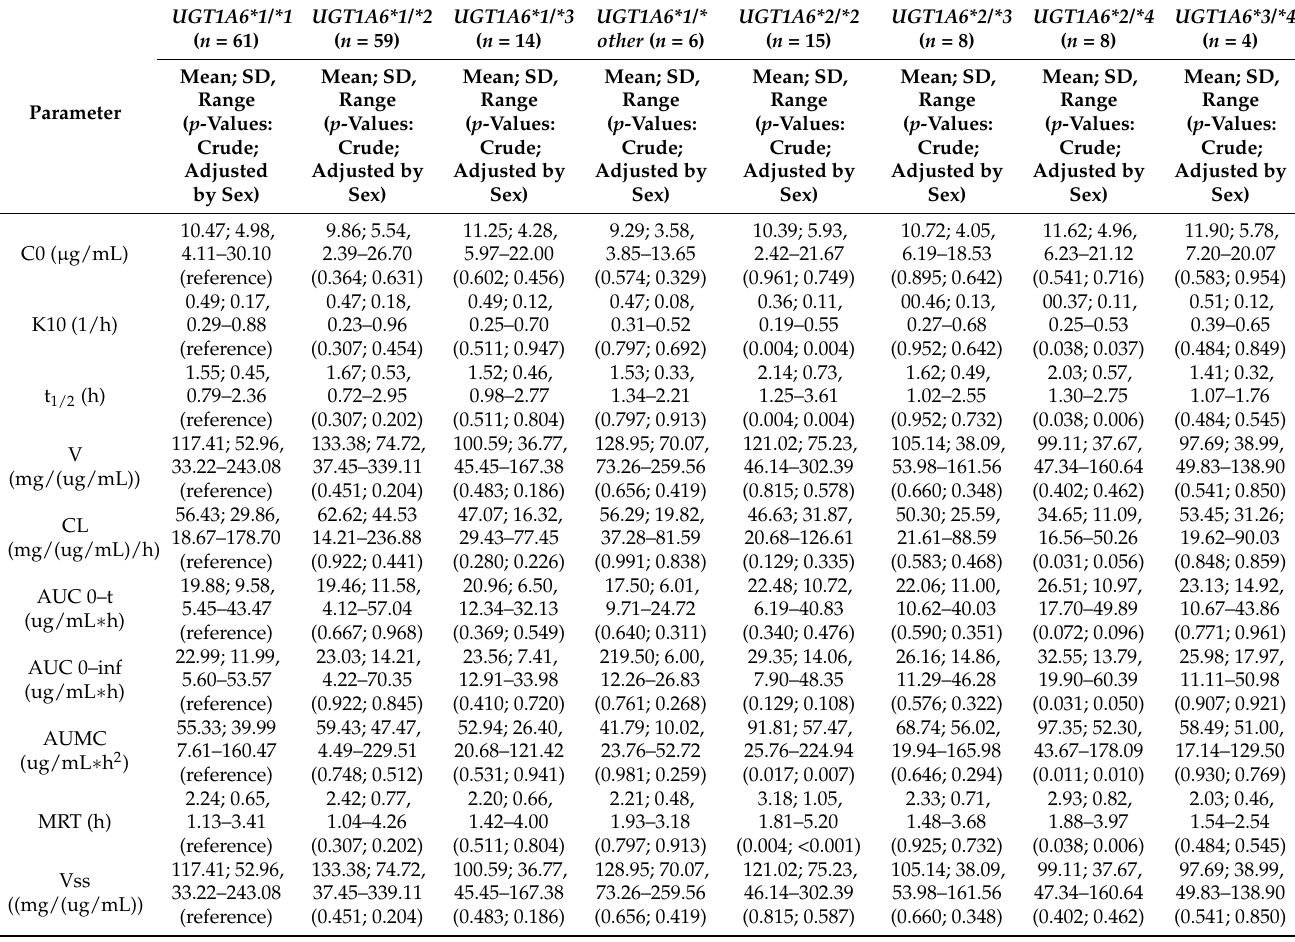
Table 7. Acetaminophen pharmacokinetics according to UGT1A6